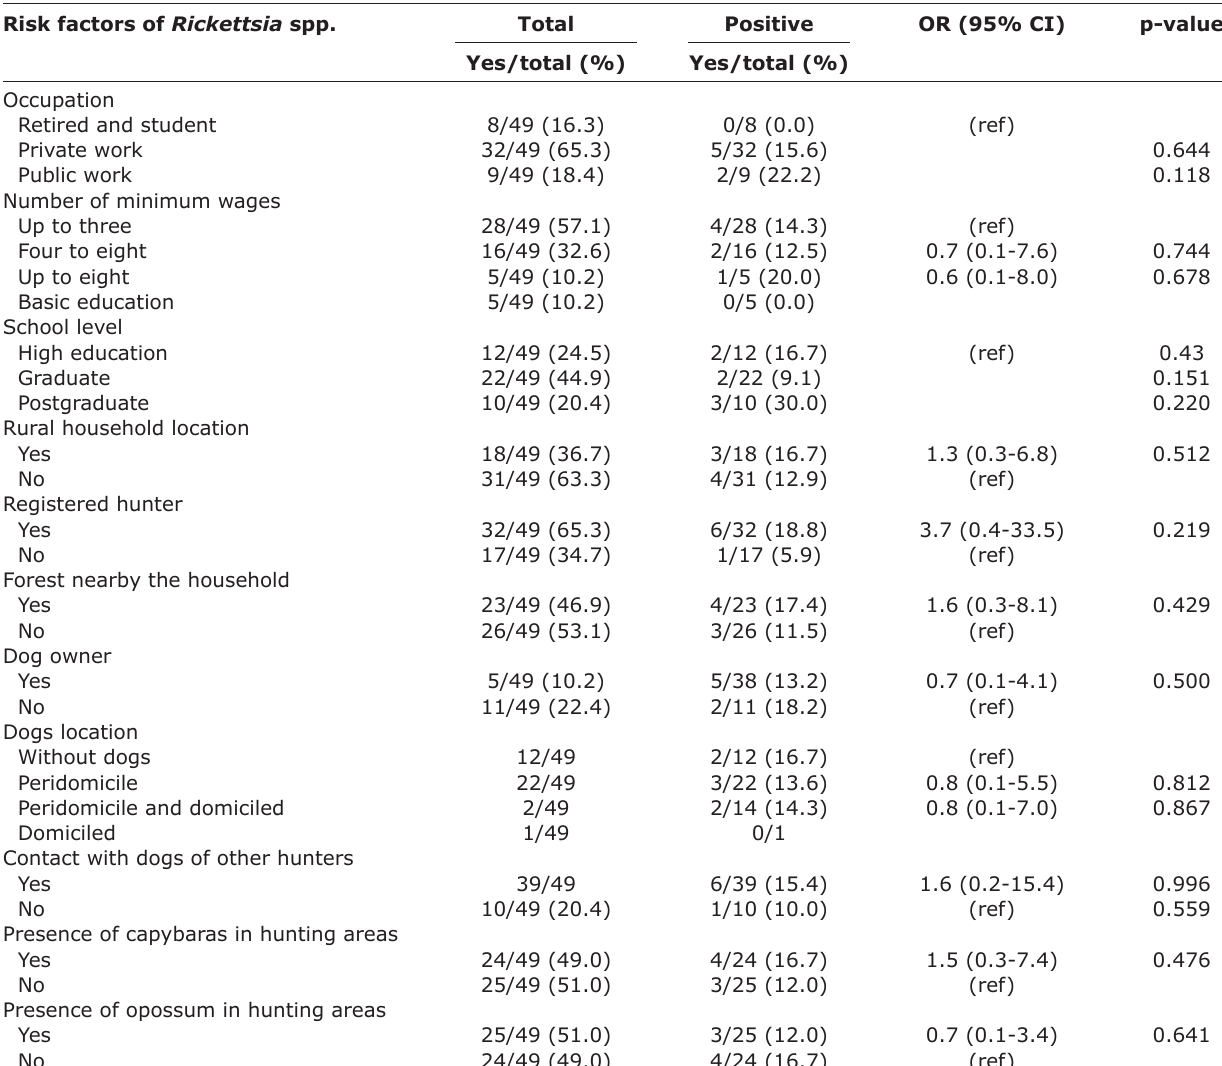
Table-1: (Continued) . Risk factors of Rickettsia